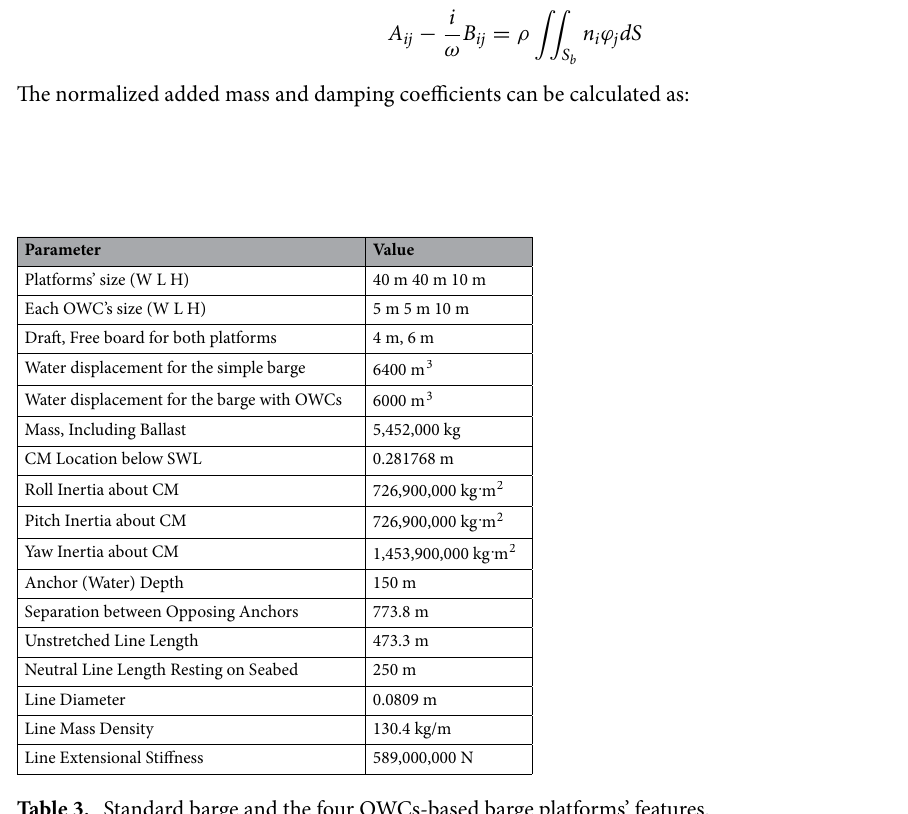
Table 3. Standard barge and the four OWCs-based barge platforms’